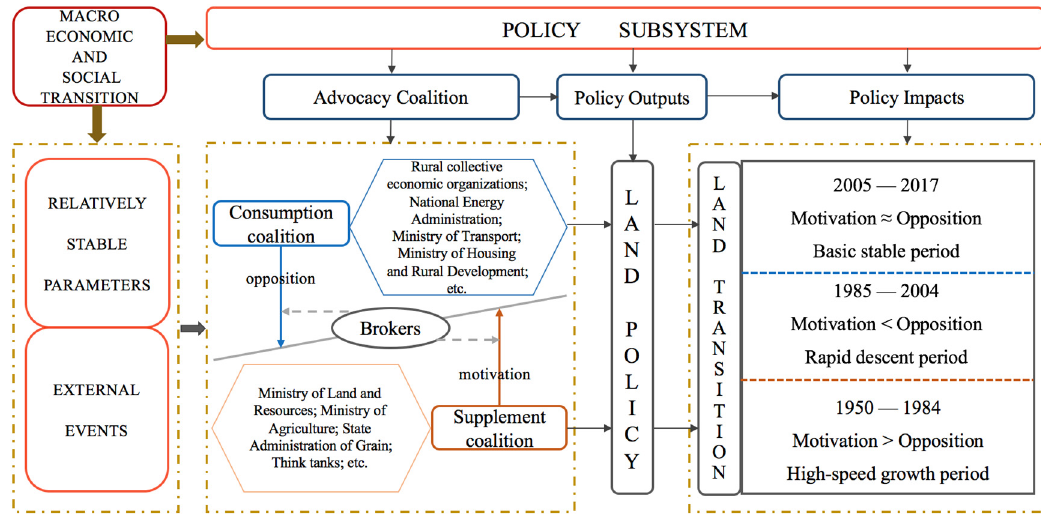
Figure 6. China’s farmland transformation mechanism from the perspective of the Advocacy Coalition Framework.